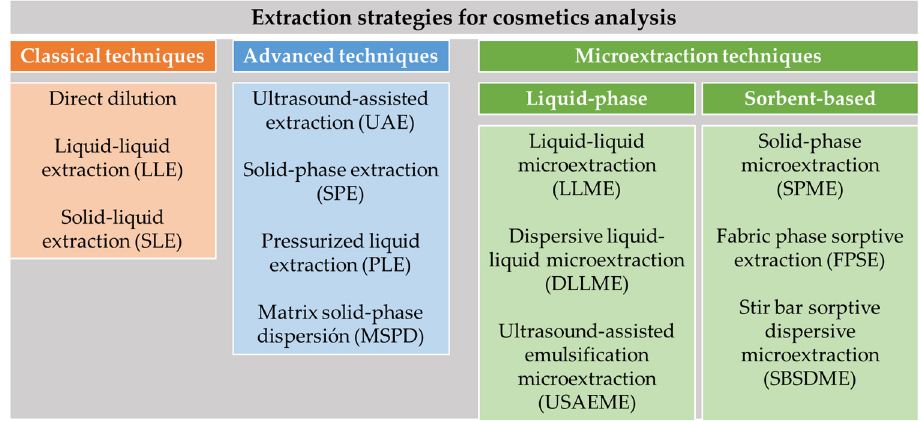
Figure 1. Sample preparation techniques for cosmetics analysis included in this review.